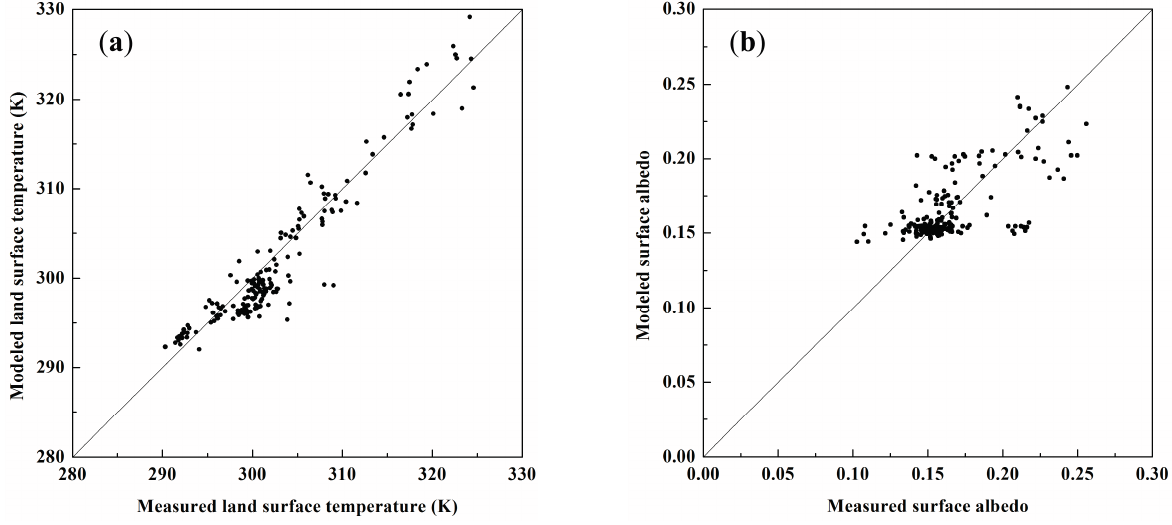
Figure 2. Comparison between the modeled and measured land surface parameters, ( a ) is land surface temperature and ( b ) is surface